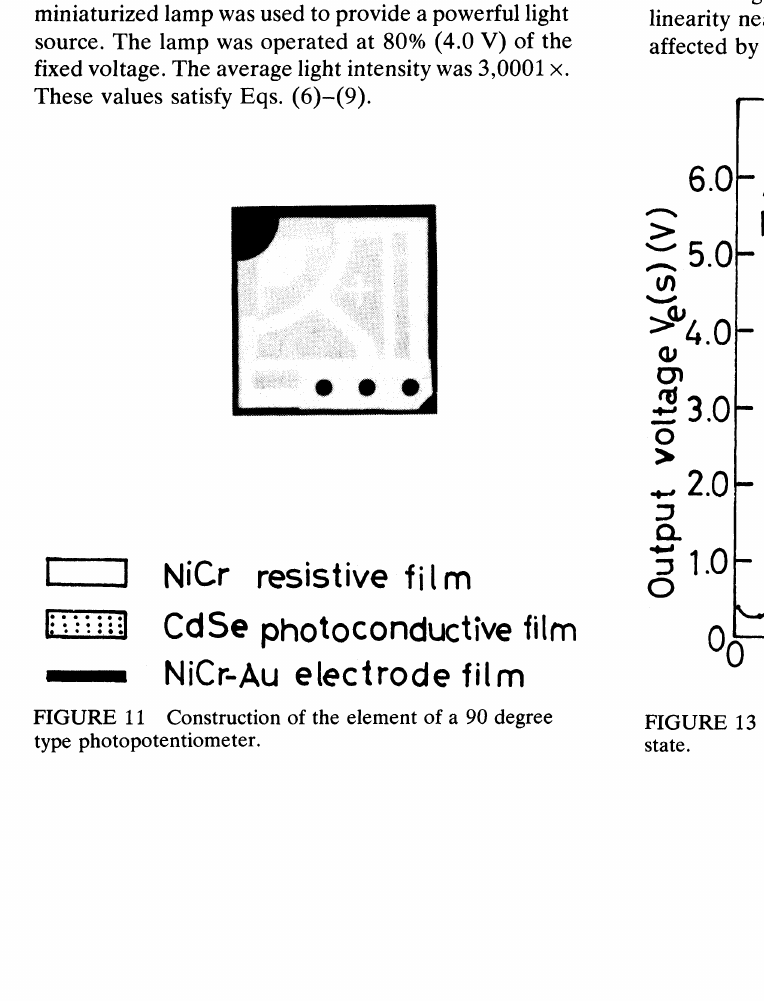
FIGURE 13 Angle-output voltage characteristic at static